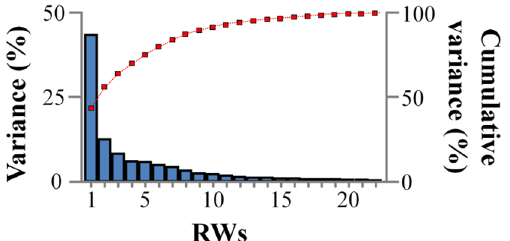
Figure 1. Variance explained by the twenty-two relative warps (RWs).